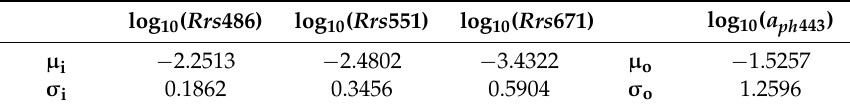
Table A1. Mean and standard deviation of the NN trained Inputs and